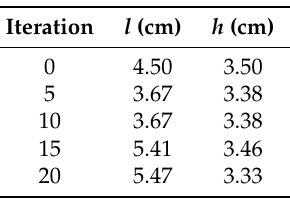
Figure 16. Proposed robot (CIQR). Table 5. Result of leg structure optimization with different numbers of